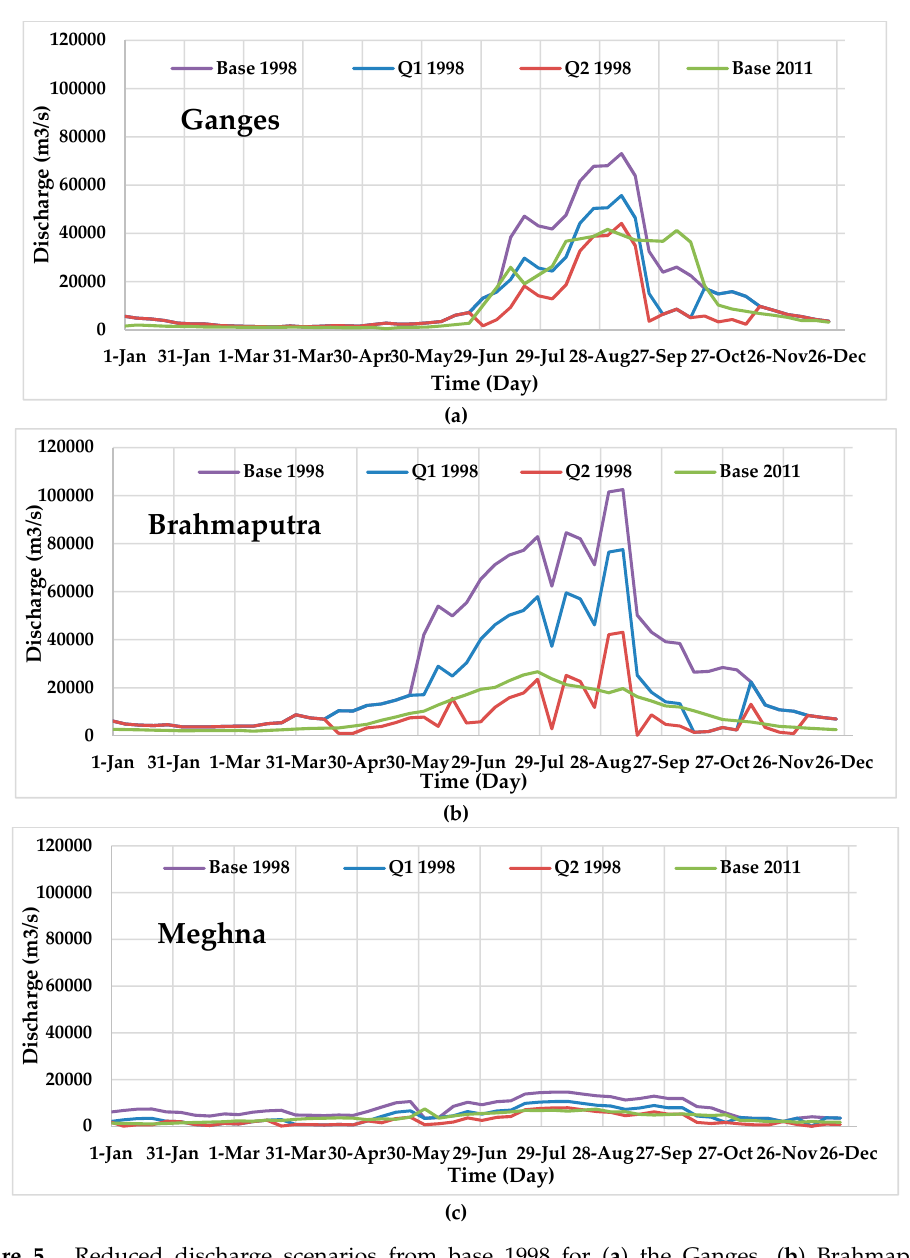
Figure 5. Reduced discharge scenarios from base 1998 for (a) the Ganges, (b) Brahmaputra, and (c) Meghna rivers